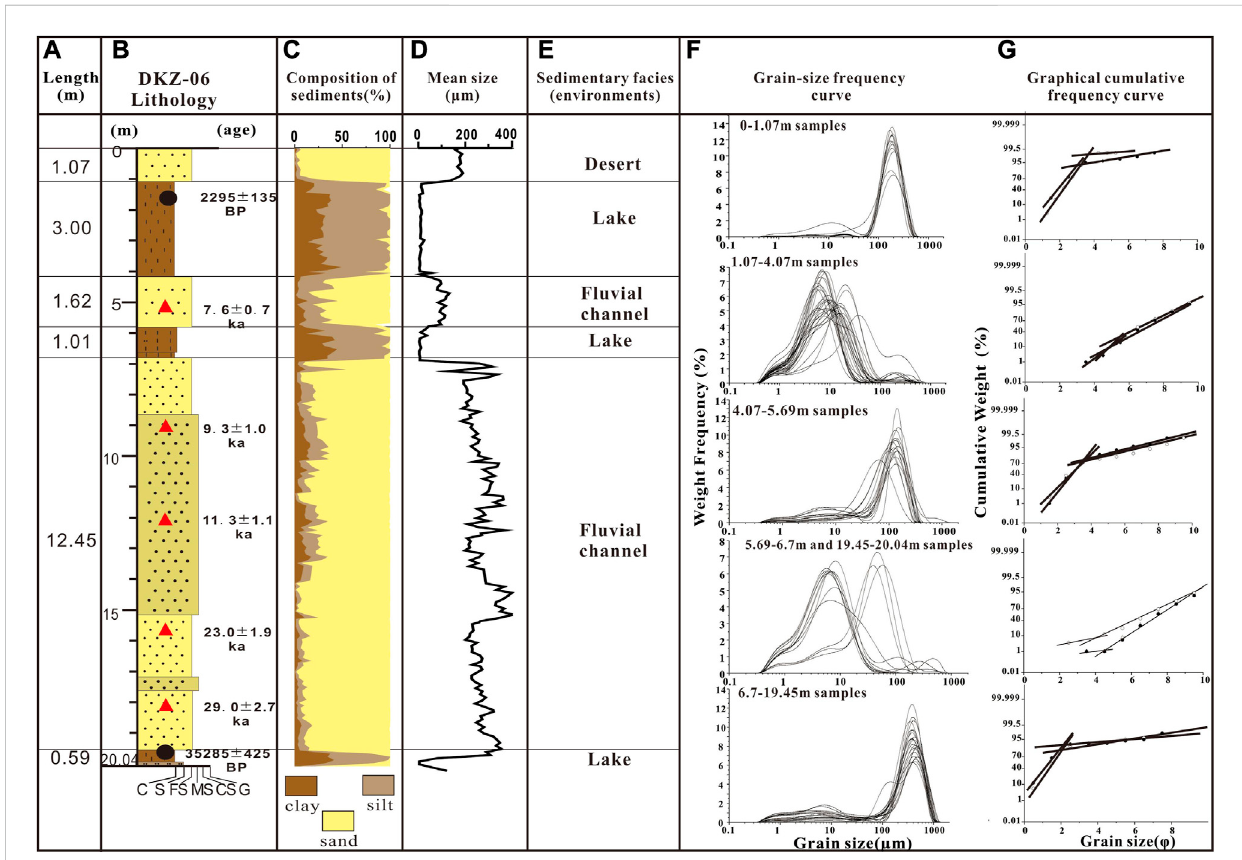
FIGURE 3 Grain-size and classi fi cation ofsedimentary facies inthedrilling core DKZ06. (A) Length of eachsedimentary facies. (B) Lithologyof thedrilling core DKZ06and datingresults. (C) Grain-size composition ofdrilling coresediments. (D) Mean sizeofdrillingcore sediments. (E) Sedimentaryfaciesbased on grain-size characteristics. (F) Grain-size frequency curves of core sediments in different units. (G) Graphical cumulative frequency curves of core sediments in different